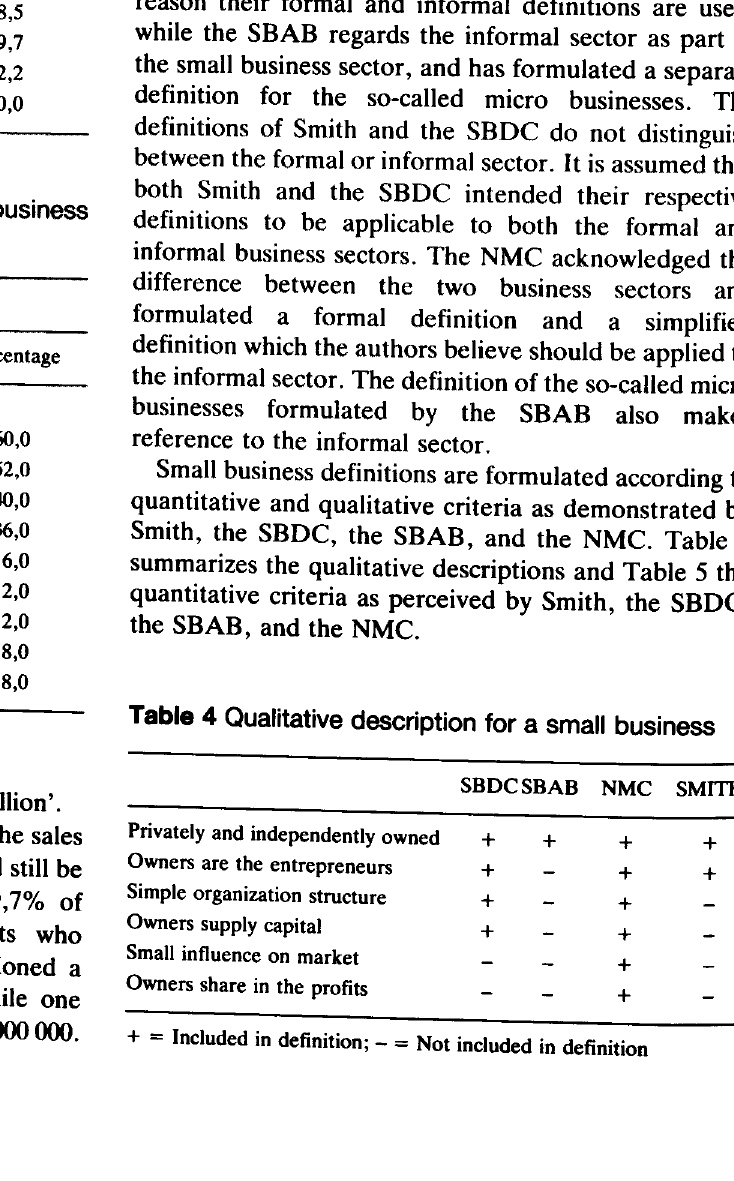
Table 3 Major dimensions of suggested small business